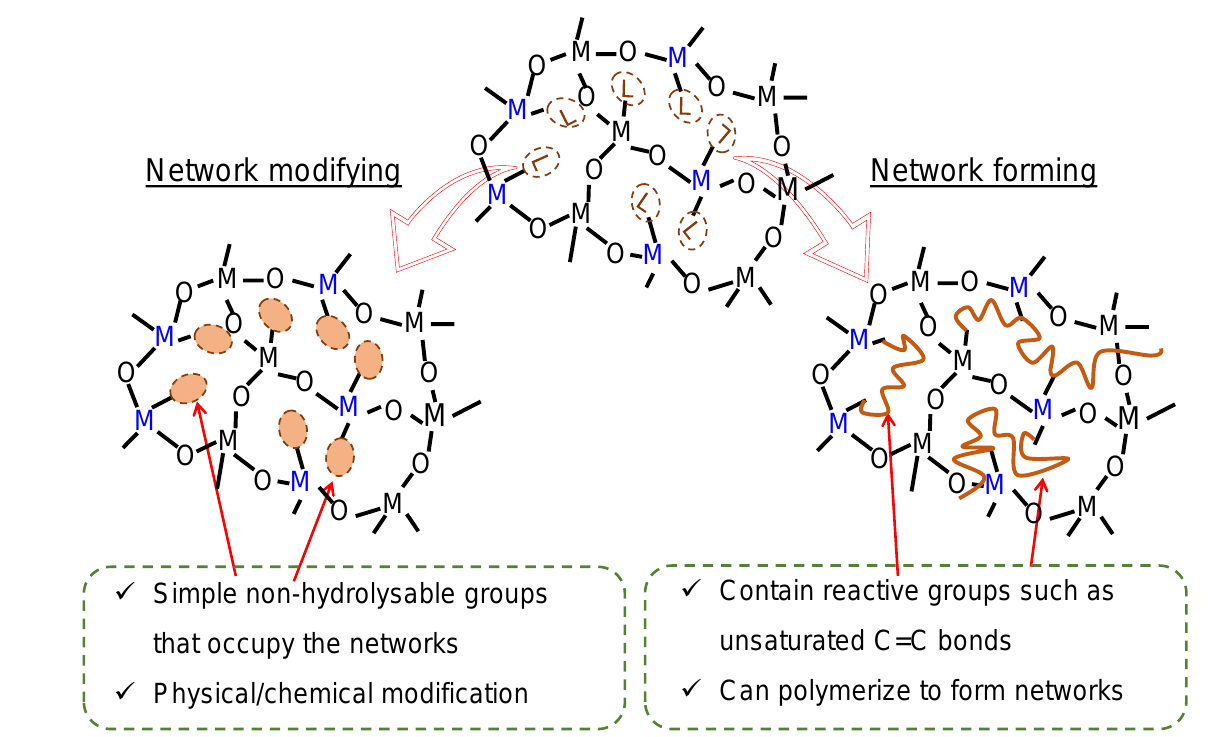
Figure 7. Illustration of network modification and network formation in organic chelating ligand- modified ceramics.